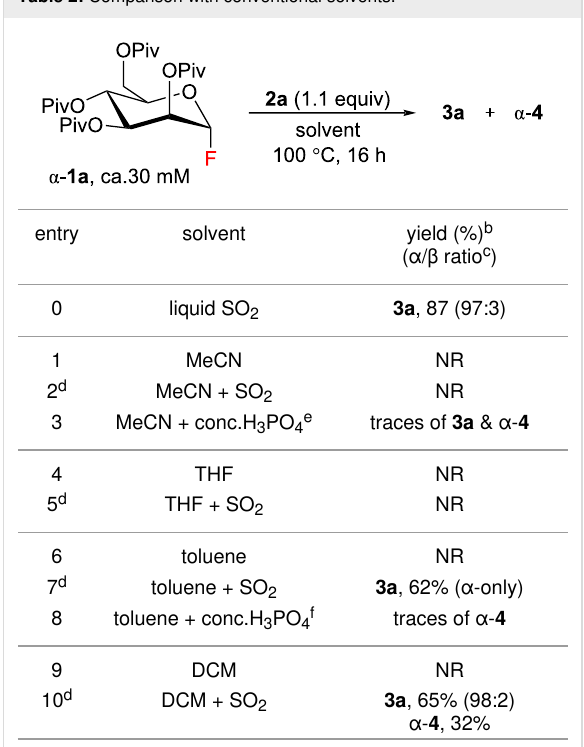
Table 2: Comparison with conventional solvents.